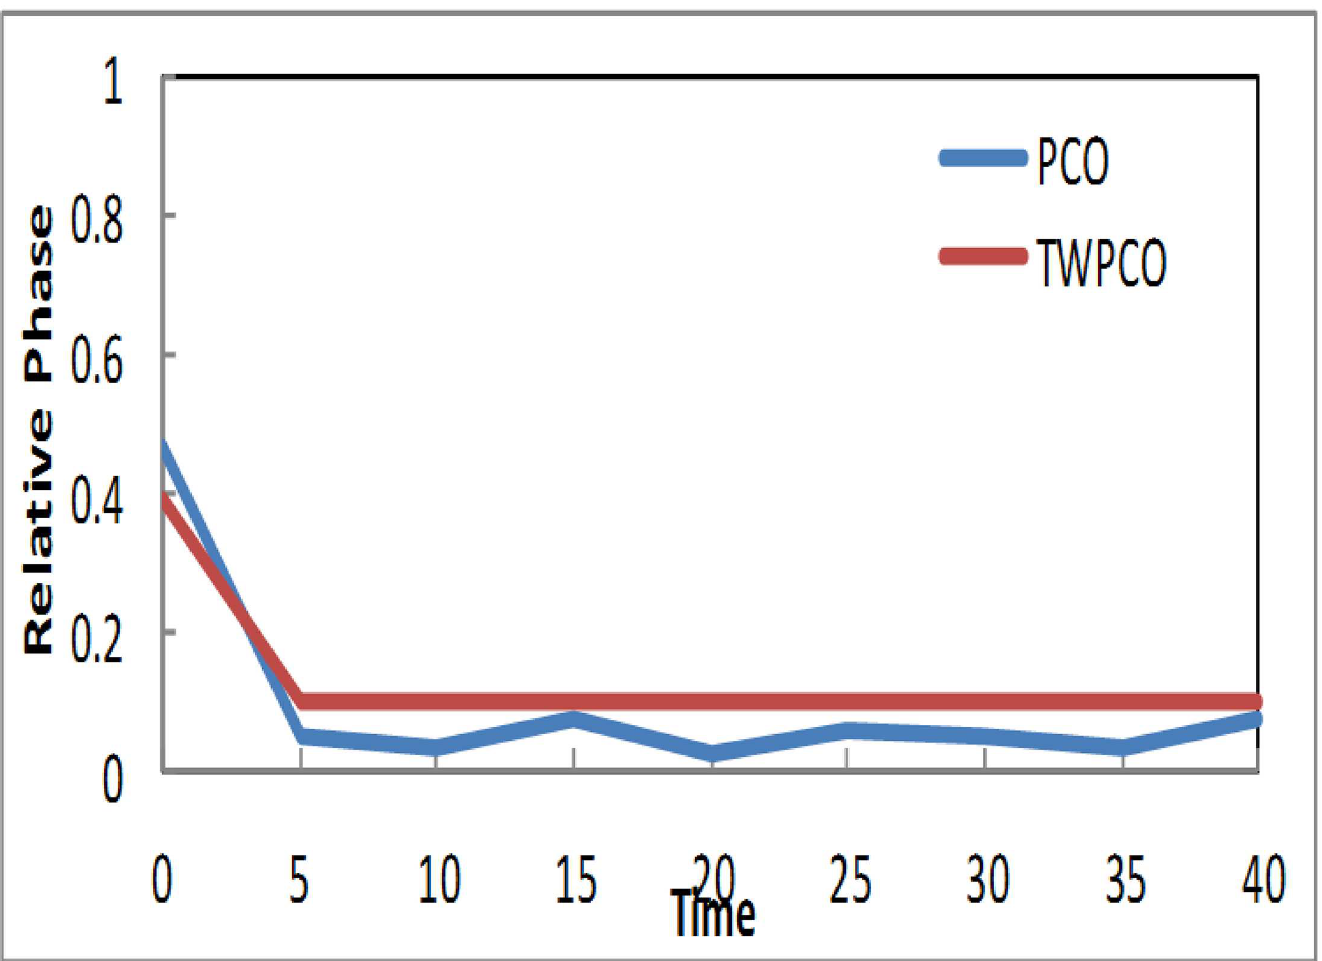
Fig 8. Relative Phase of Sensor TWPCO and PCO in regard to Node